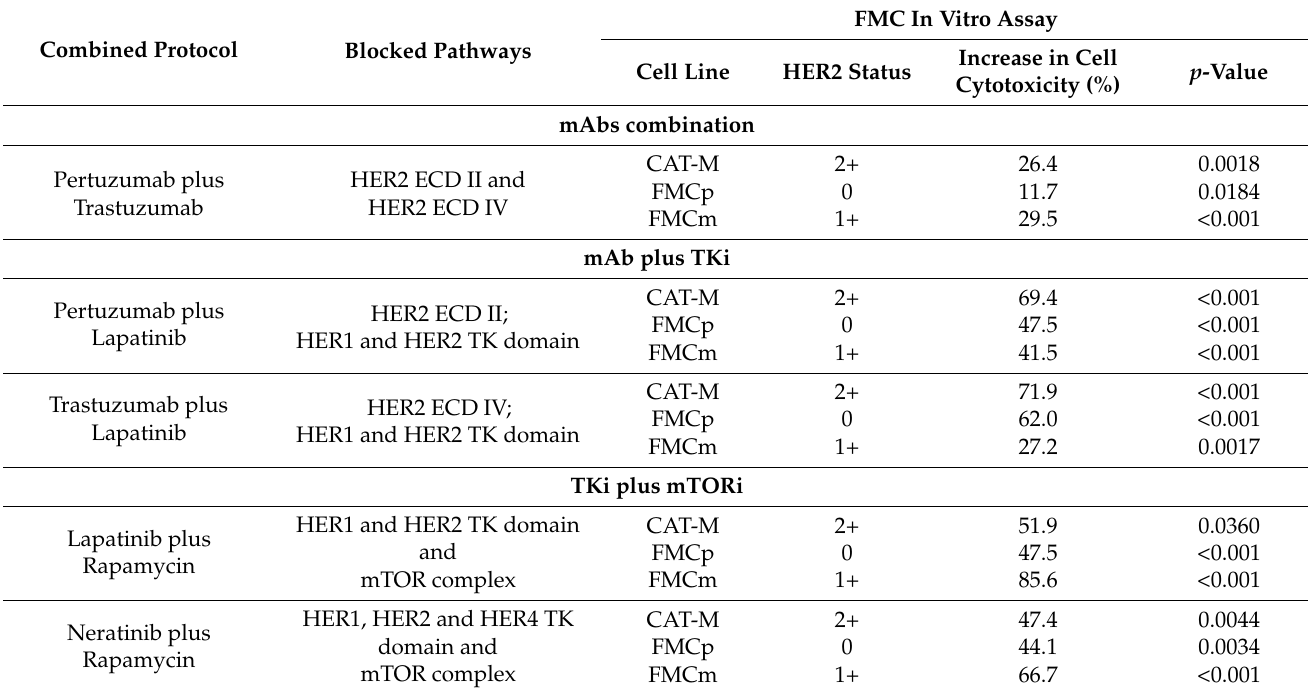
Table 5. Combined protocols present synergistic antiproliferative effects in FMC cell-based models by blocking different HER2 pathways